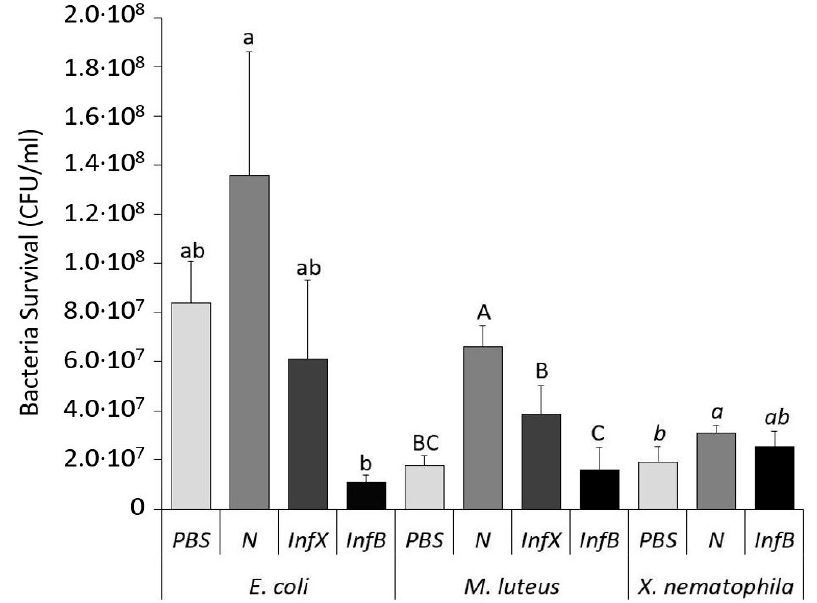
Figure 3. Antimicrobial activity of D. suzukii hemolymph after bacterial infection evaluated through co-incubation with E. coli , M. luteus , and X. nematophila . Host hemolymph samples were from PBS-control (PBS), naïve larvae (N), infected with X. nematophila (InfX), and with E. coli / M. luteus (InfB). Survival of E. coli, M. luteus, and X. nematophila are shown as the mean ± SD of CFU/ml. Different letters on the bars represent statistically significant differences among each antimicrobial sample. GLM of E. coli: F = 8.39, df = 3, p = 0.007; GLM of M. luteus: F = 21.73, df = 3, p < 0.001; GLM of X. nematophila : F = 3.66, df = 2, p = 0.091.